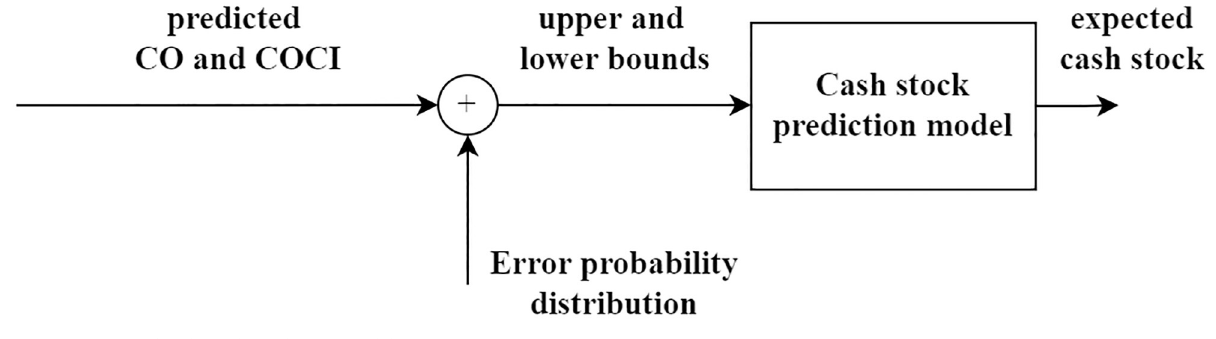
Fig 7. Diagram of cash stock prediction